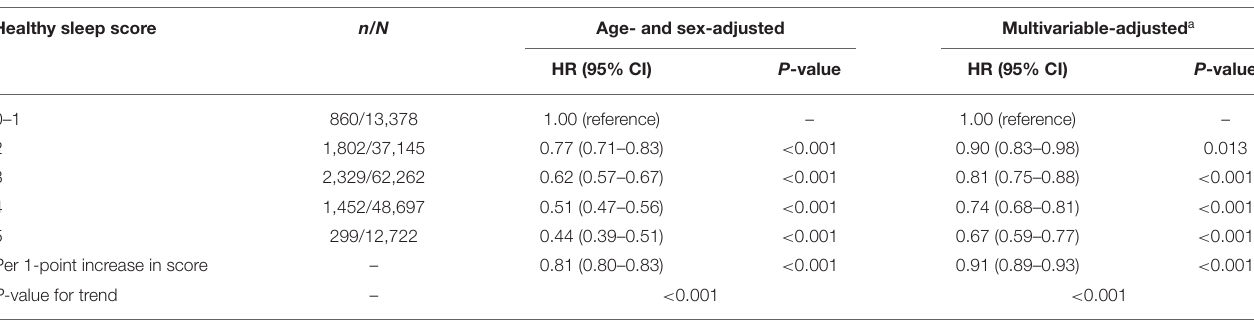
TABLE 3 | Association between healthy sleep score and incident